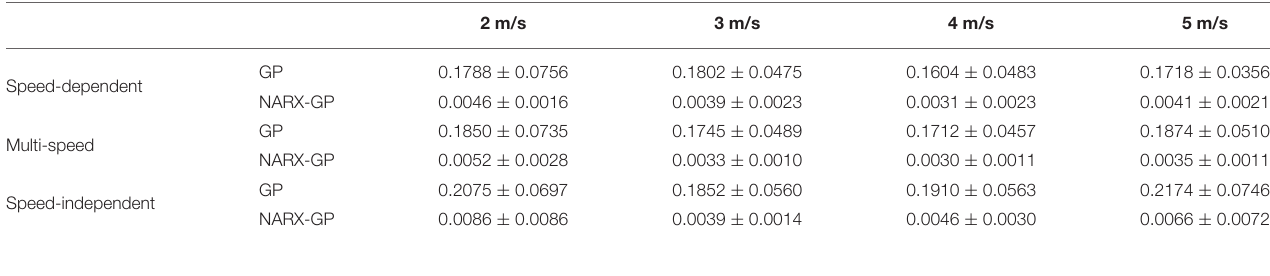
TABLE 1 | NRMSE between the estimated joint torque of different models and the measurements (“true” values) of all subjects (mean ± std).